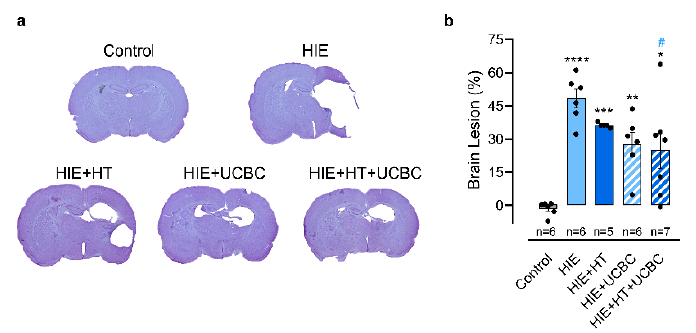
Figure 1. Intravenous administration of UCBC reduced the extension of the brain lesion evaluated 30 days after neonatal HI injury. ( a ) Representative images of brain sections stained with Cresyl Violet acquired at 5 × magnification and ( b ) quantification of the brain lesion at P40, calculated as the ratio of the volume of the ipsilateral hemisphere to the contralateral hemisphere of 16 sequential sections. Data are expressed as mean ± SEM of five to seven animals per group (Table S5). Statistical analysis was performed using one-way ANOVA coupled with Tukey’s multiple comparison test (* p < 0.05, ** p < 0.01,*** p < 0.001, and **** p < 0.0001 compared to the control; # p < 0.05 compared to HIE; Table